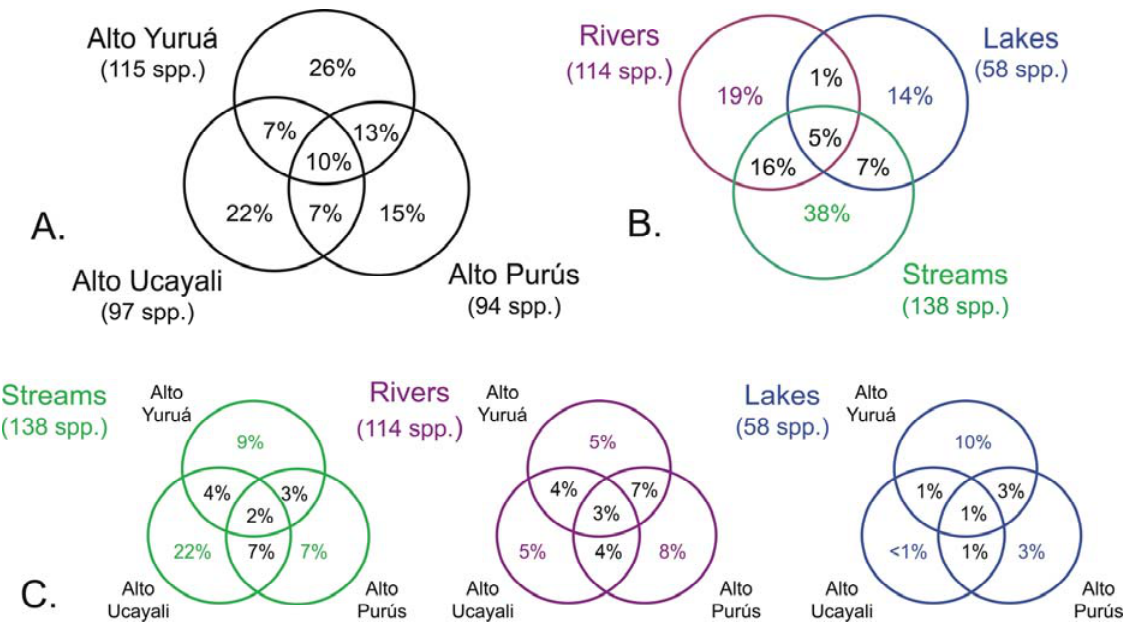
Figure 4. Venn diagrams summarizing shared fish species compositions of subregions (river basins) and major habitat types. ( A ) Among basins, habitats pooled. ( B ) Among habitats, basins pooled. ( C ) Among basins by habitat. Data presented as percentages of total Fitzcarrald species pool (208 species) to facilitate